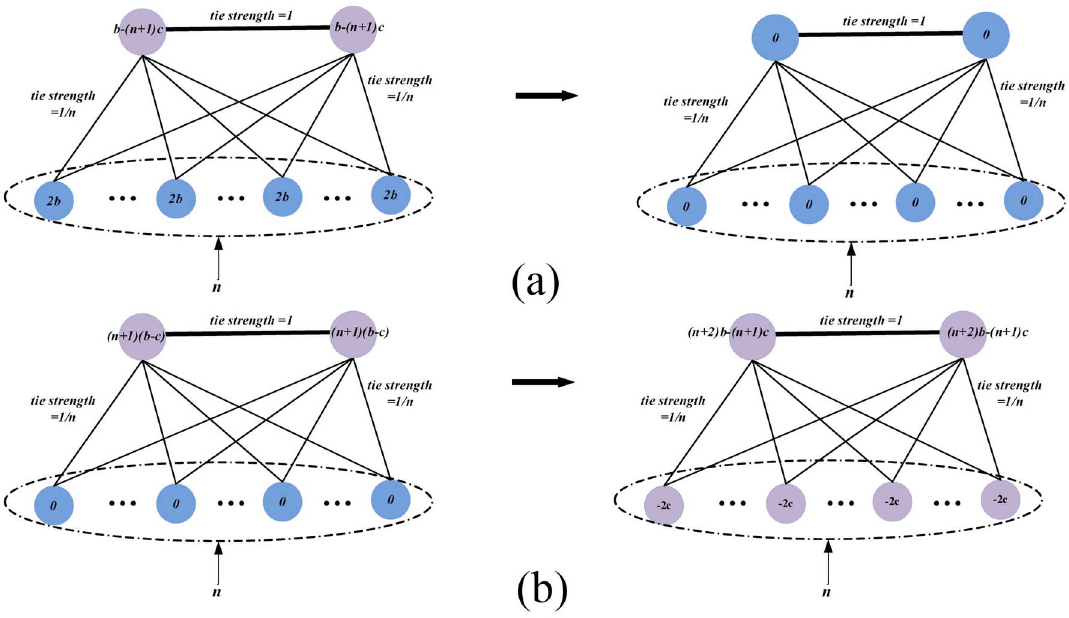
Figure 5. A simple illustration of the influence of a on the evolution of cooperation in PDG. Here, pink nodes denote cooperators and blue nodes denote defectors. All the two top nodes’ friends overlap, therefore the tie strength between them equals one. All other relations have a tie strength equals 1 = n . We set the two mutual best friends as cooperators initially. (a) When a ~ 0 , the game is a classical PDG. The two cooperators get a payoff of b { ( n z 1 ) c and all the defectors get 2 b . Therefore, cooperators will imitate the strategy of defectors and defection becomes prevalent; (b) When a ~z ? , the two cooperators will invest all their investments to each other. Both cooperators get ( n z 1 )( b { c ) and all defectors get 0. Therefore, in the next round, all defectors will adopt C and cooperation becomes prevalent.